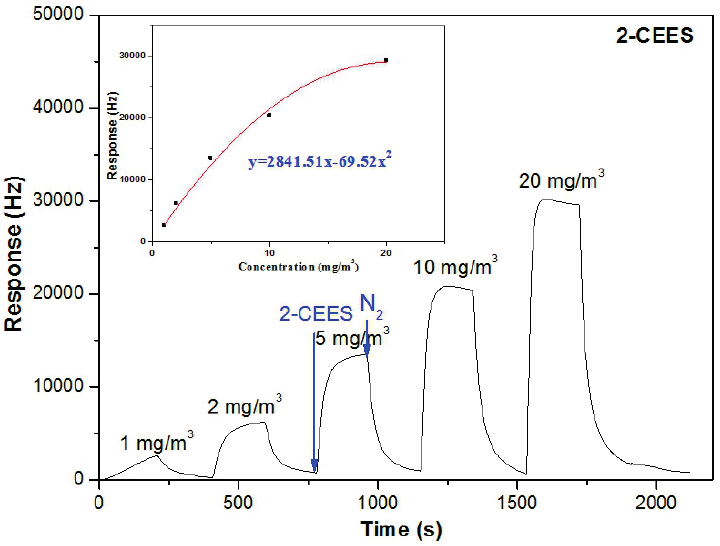
Figure 5. Response variations of the PLF sensor in terms of the concentration change of 2-CEES (3 min 2-CEES and 3 min N 2